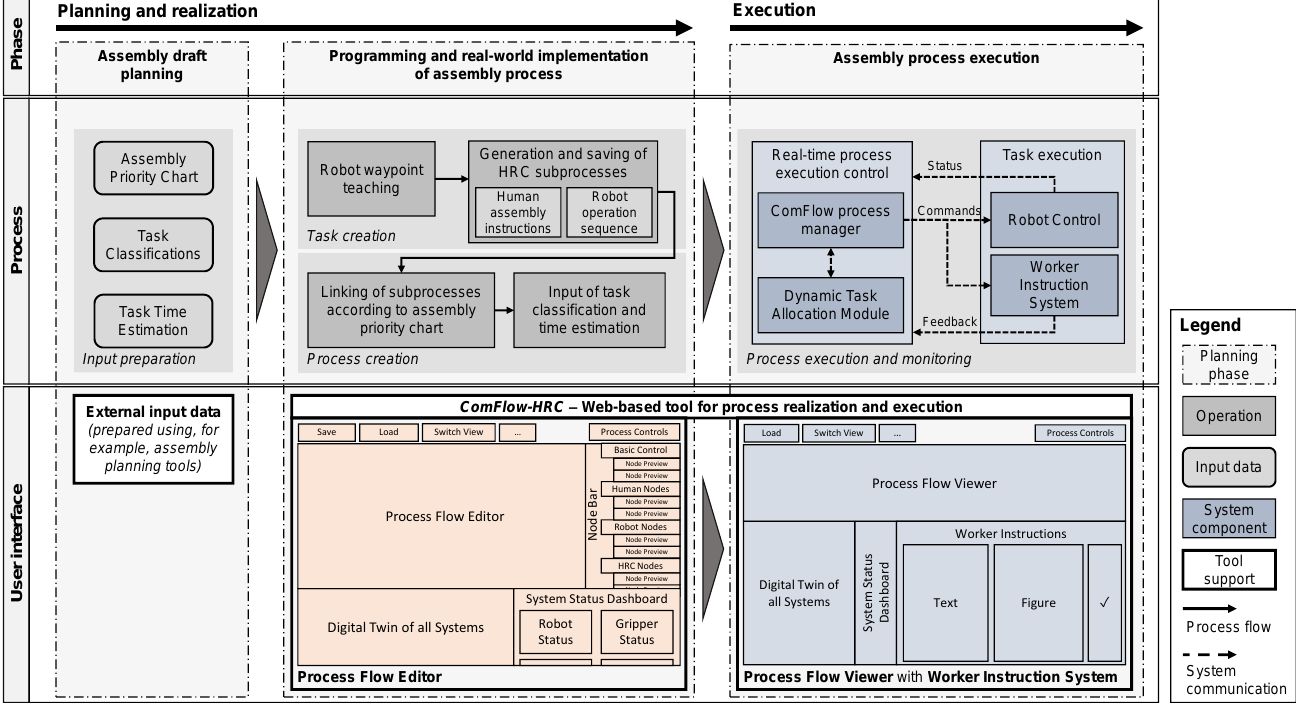
Figure 4. Process for implementation and execution of assembly processes with the software framework and illustration of the conceptual user interfaces.